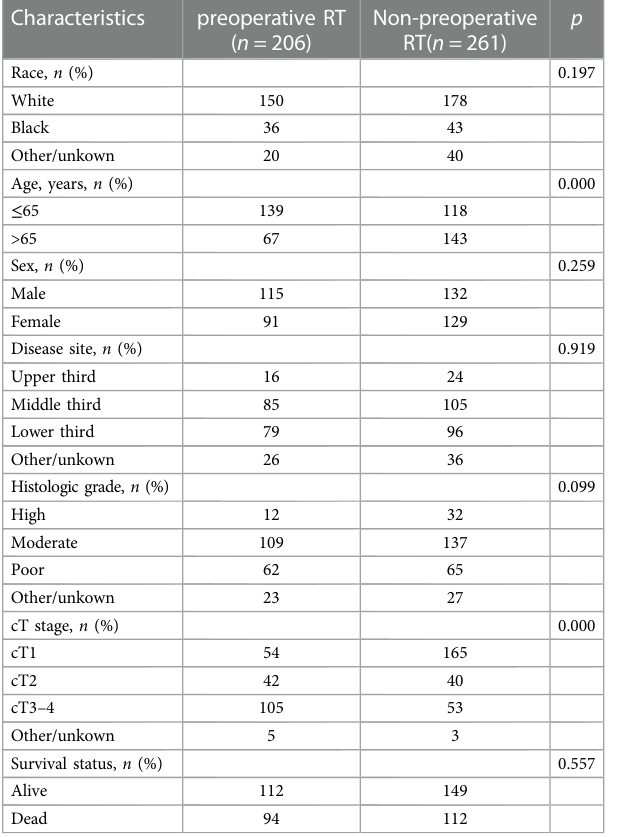
TABLE 1 Comparison of patient demographics and tumor characteristics for the clinical node-negative patients before propensity score matching.